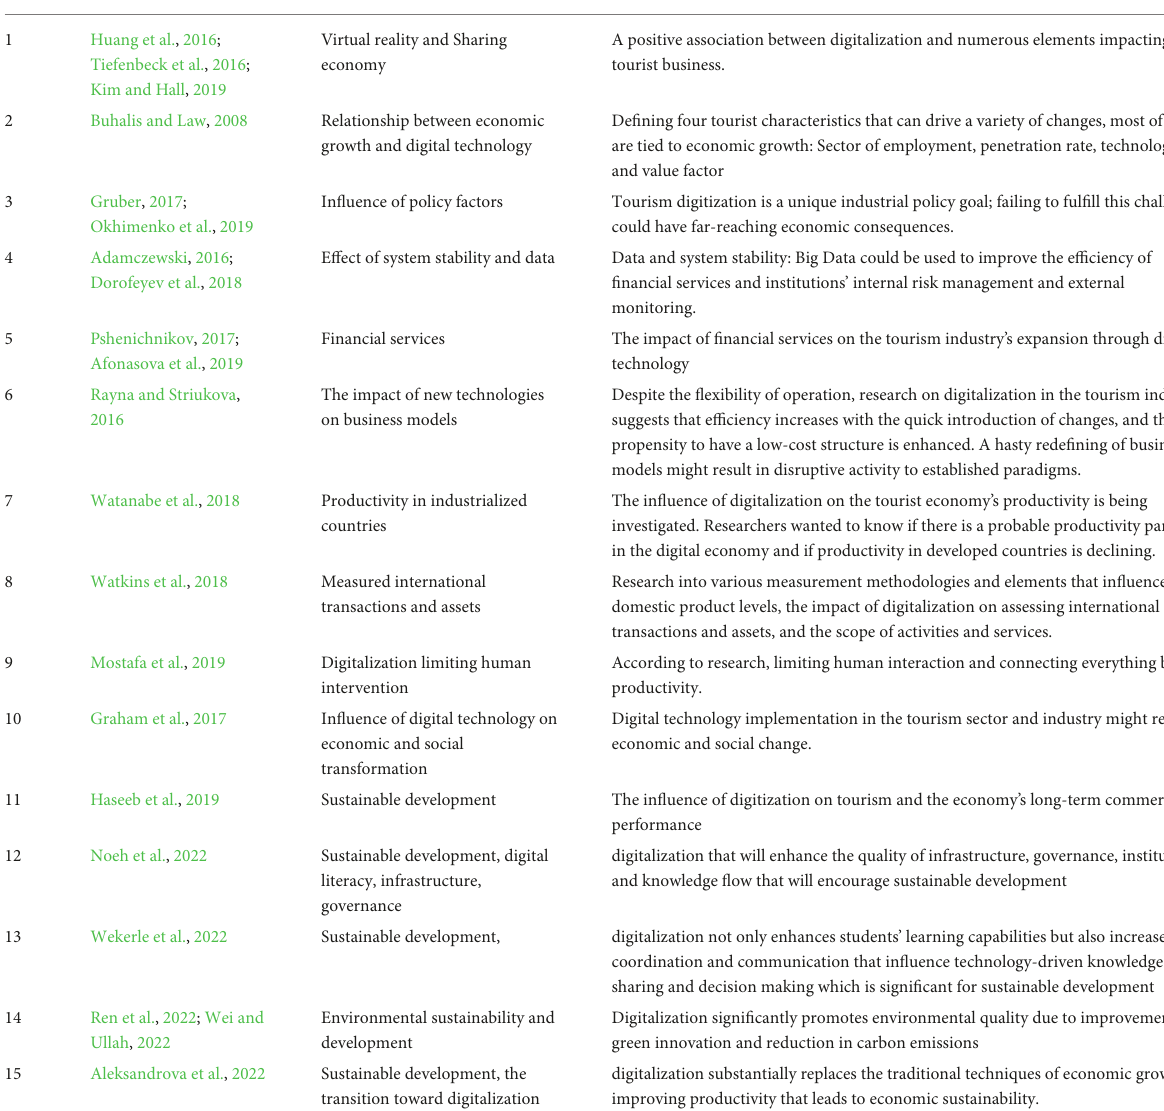
TABLE 1 Literature review of digitalization, sustainable development, and